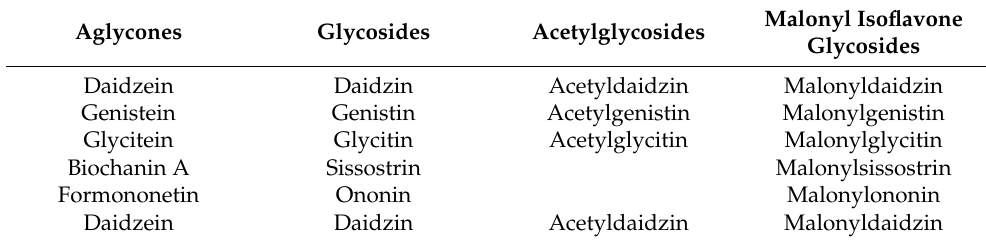
Table 3. Four chemical forms of main